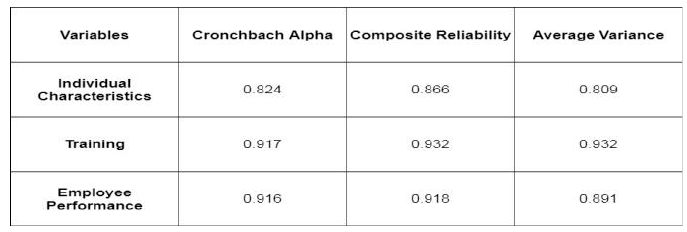
Table 1 : Cronbach Alpha, Composite Reliability, Average Variance